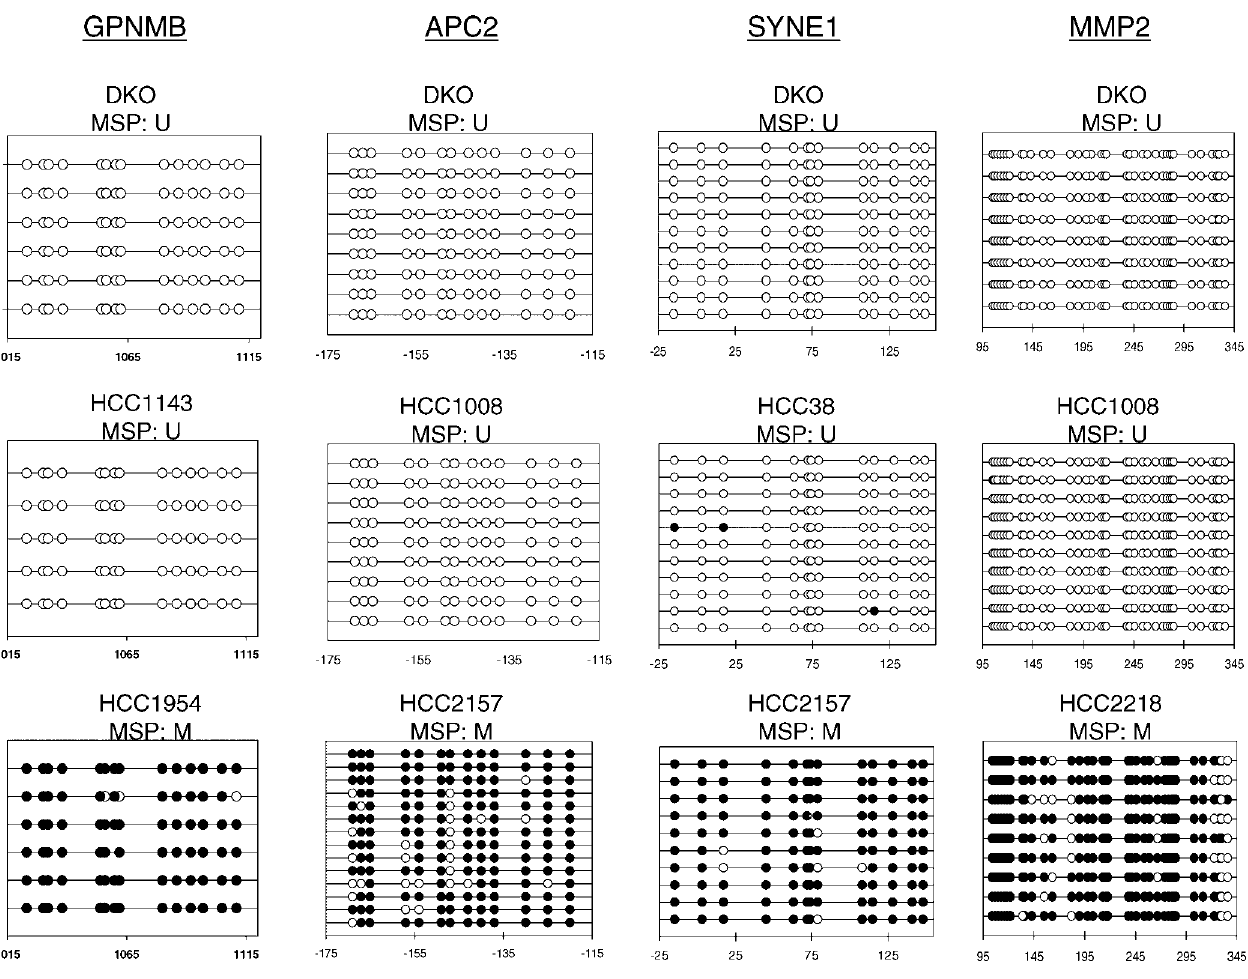
Location relative to the transcriptional start site is shown on the x -axis of each plot. Empty circles represent unmethylated CpGs, and black circles represent methylated CpGs. The corresponding results obtained with MSP are noted above each plot.